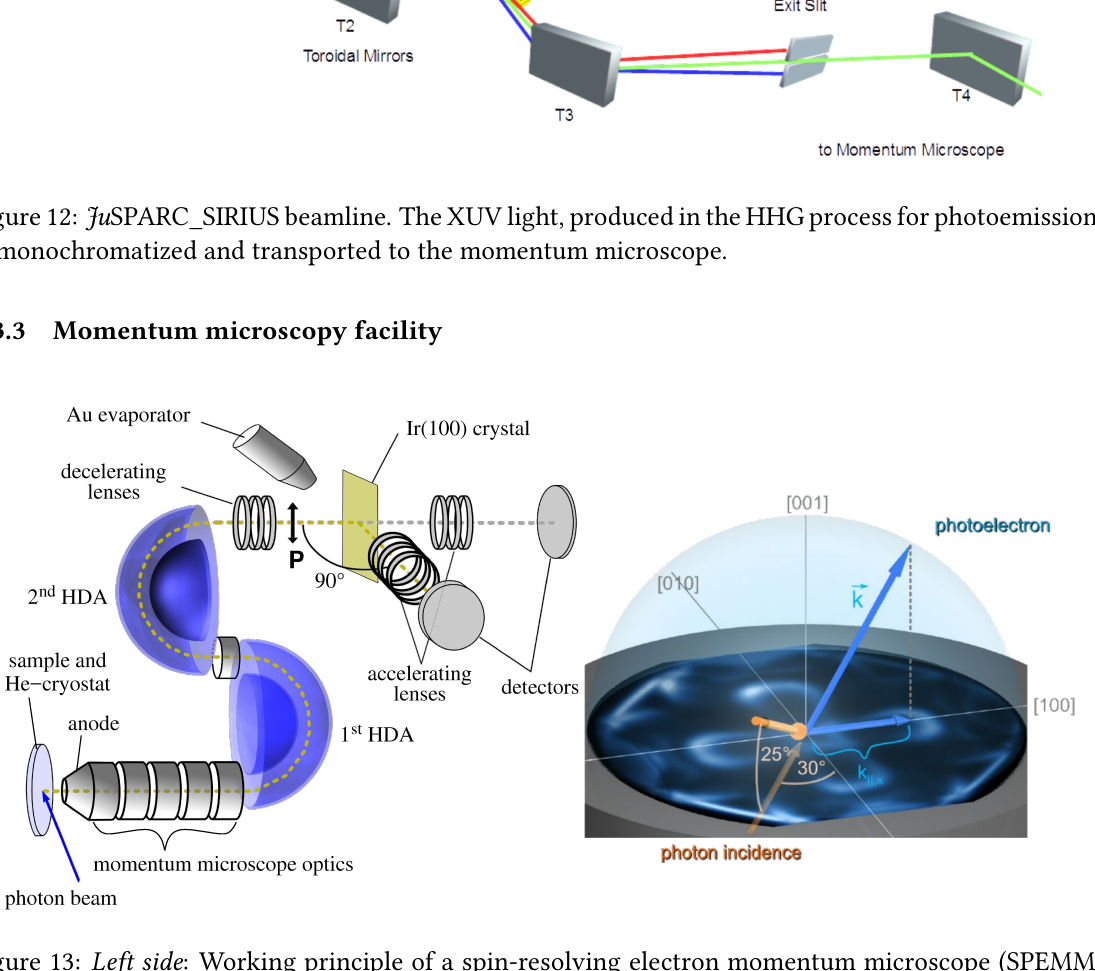
Figure 13: Left side : Working principle of a spin-resolving electron momentum microscope (SPEMM) consisting of the imaging electron optics, electrostatic energy filter, imaging spin-filter with Ir(100) mirror, and detectors (Tusche et al., 2015). Right side : Emission of photoelectrons into the complete half-space above the sample surface and the related intensity distribution in reciprocal space. The SPEMM experiment collects all photoelectrons